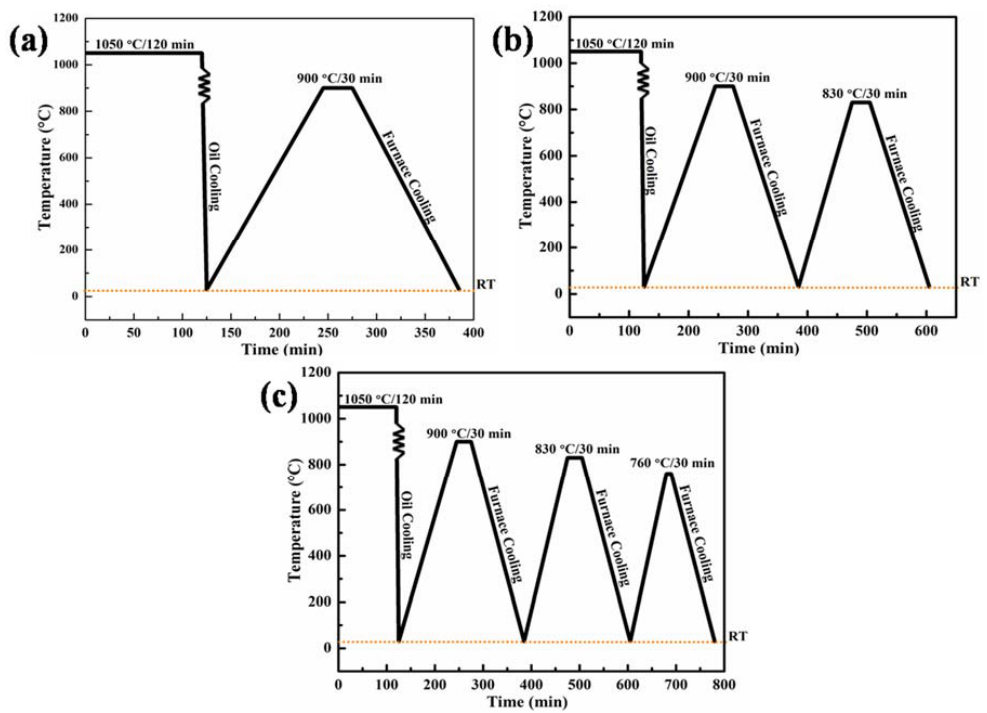
Figure 1. Schematic diagram of thermo-mechanical cyclic annealing processes; ( a ) thermo-mechanical single annealing (TMSA), ( b ) thermo-mechanical double annealing TMDA, ( c ) thermo-mechanical triple annealing (TMTA) applied to AISI 1345 steel.